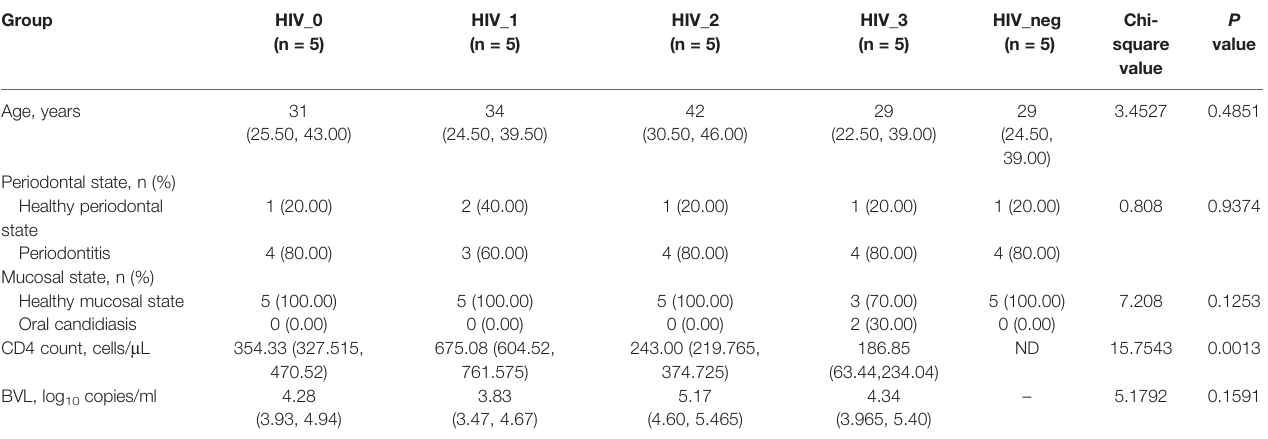
TABLE 1 | Characteristics of participants in the untreated MSM with HIV infection and control groups.